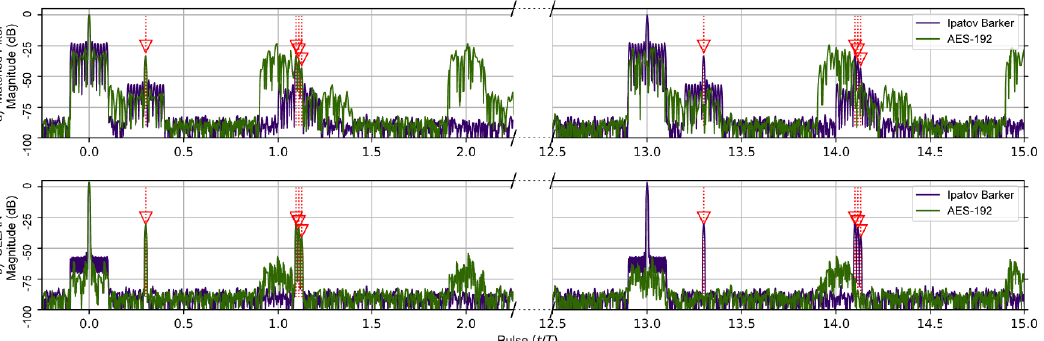
Figure 5. Ipatov–Barker method (Purple) and AES-192 method (Green) matched filter’s response for 78 simulated pulses. ( a ) Top, matched filter’s response before CLEAN. ( b ) Bottom, CLEAN Reconstructed matched filter’s response when applied to all targets. The Ipatov–Barker method begins to repeat after pulse 13, but the AES-192 method does not. The side lobes of the AES-192 method are reduced by